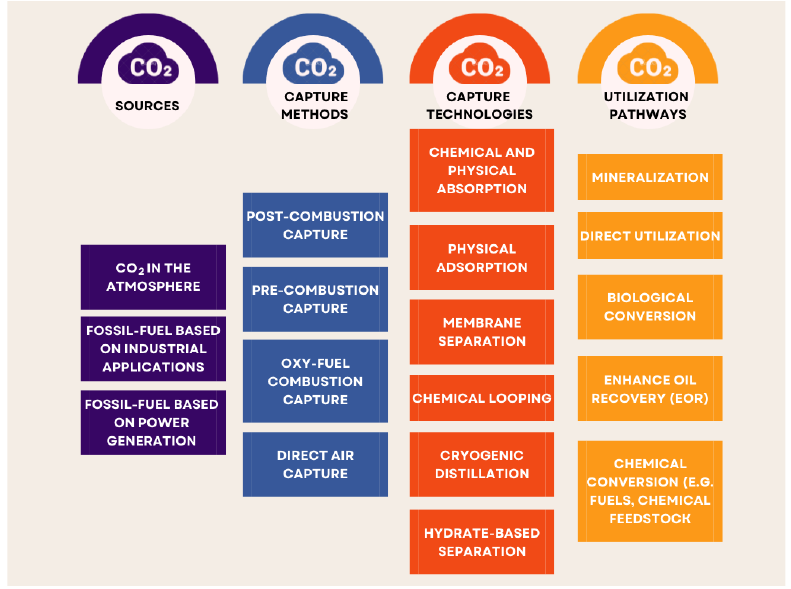
Figure 7. CCUS — set of technologies (based on [41–44]). Figure 7. CCUS—set of technologies (based on [41–44]).